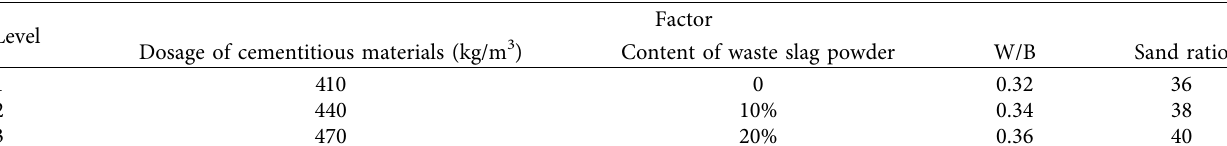
Table 10: Factor-level